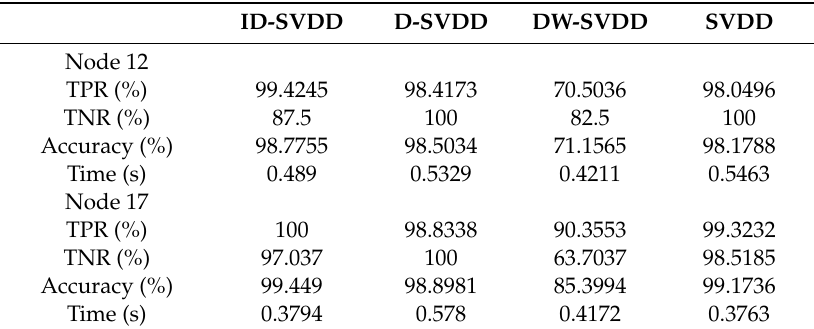
Table 4. Detection results of SensorScope datasets.